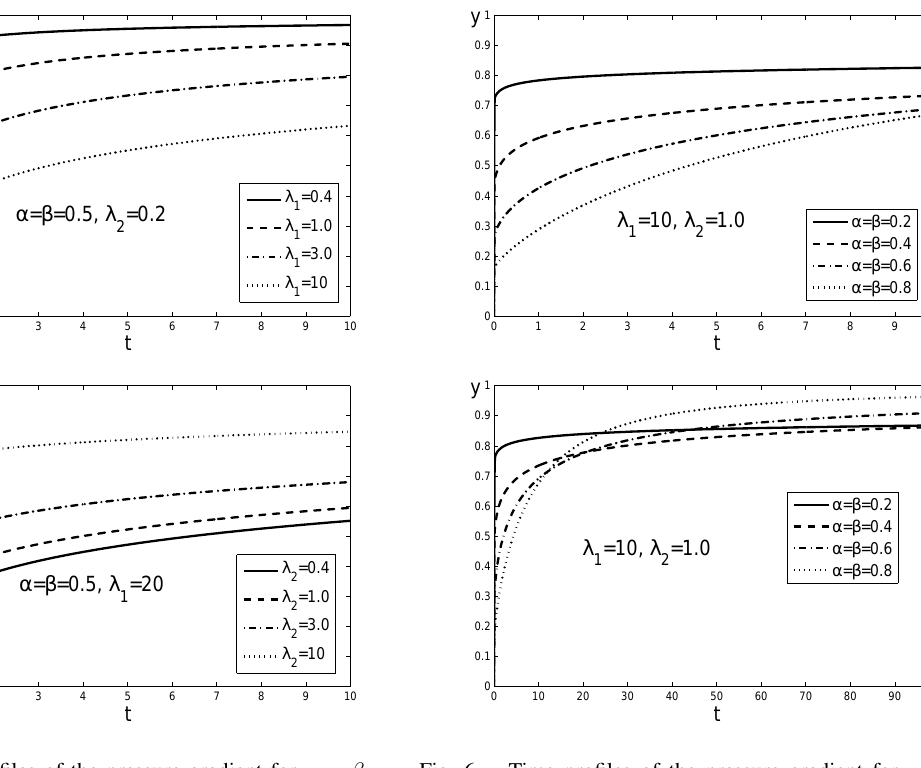
Fig. 5. Time profiles of the pressure gradient for α = β = 0 . 5 , A = 1 and various values of λ 1 and λ 2 , λ 1 > λ 2 .